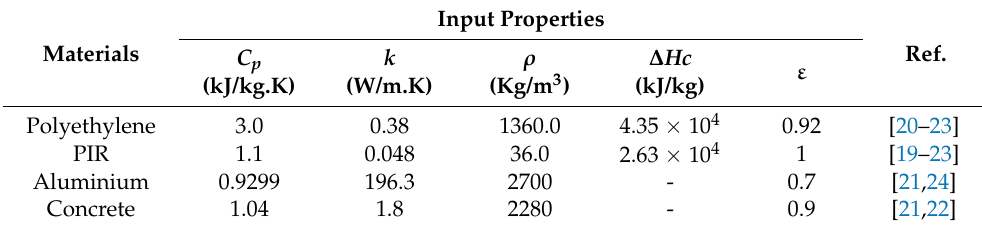
Table 2. Thermal properties used in the FDS